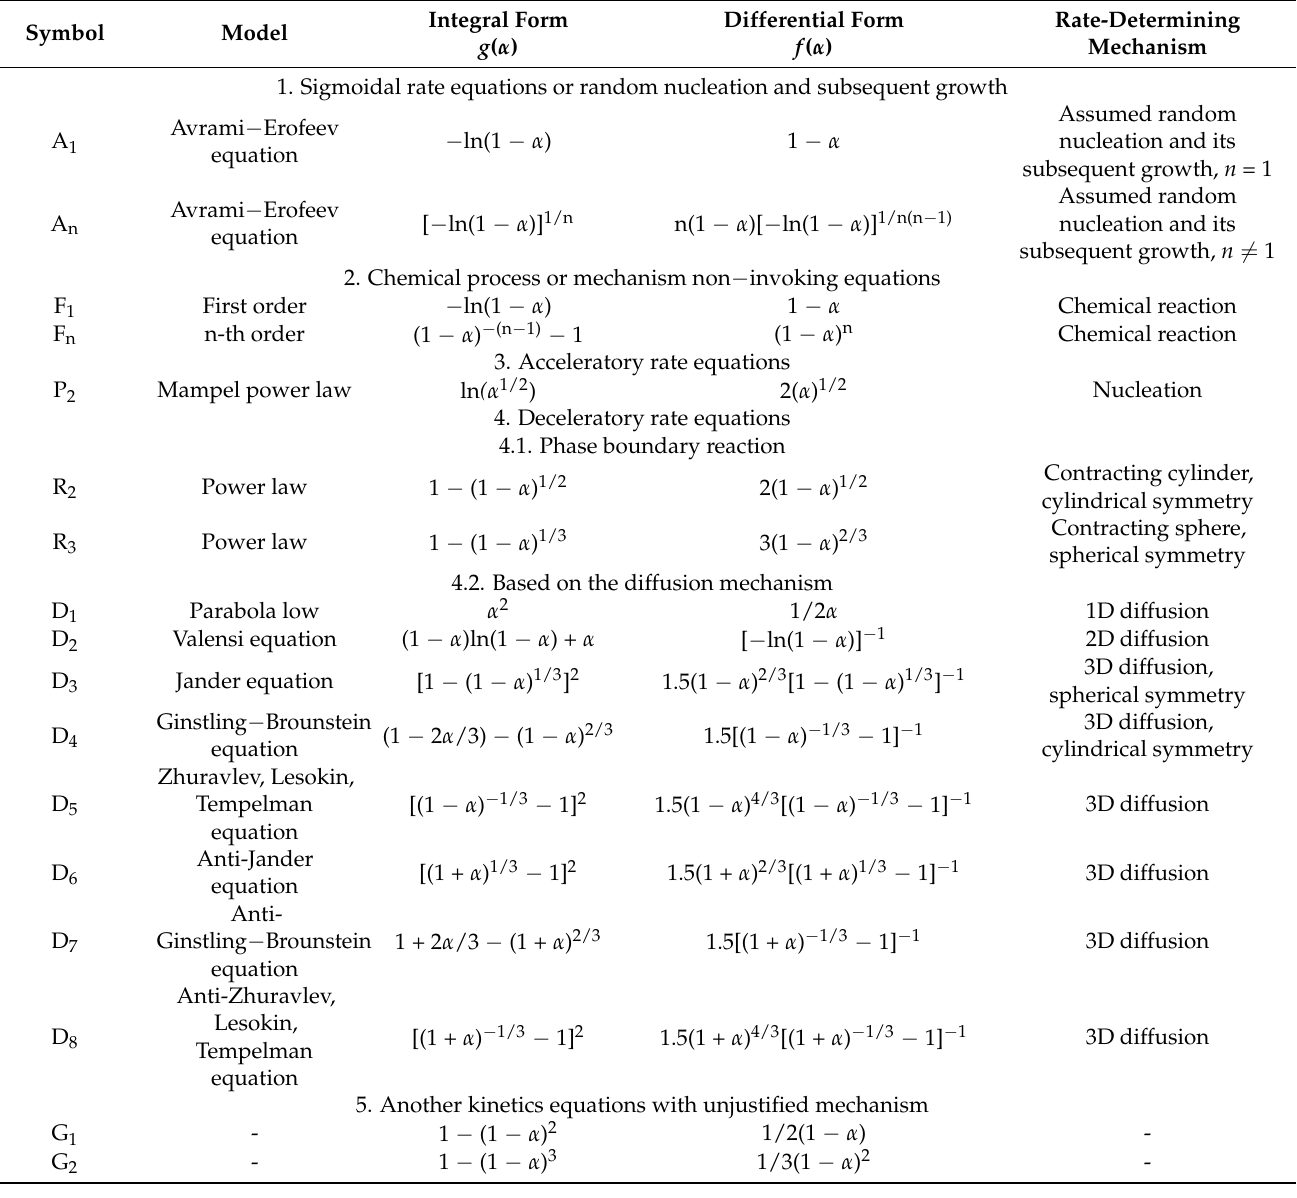
Table 1. Various kinetic models and the corresponding mechanism of the solid-state process